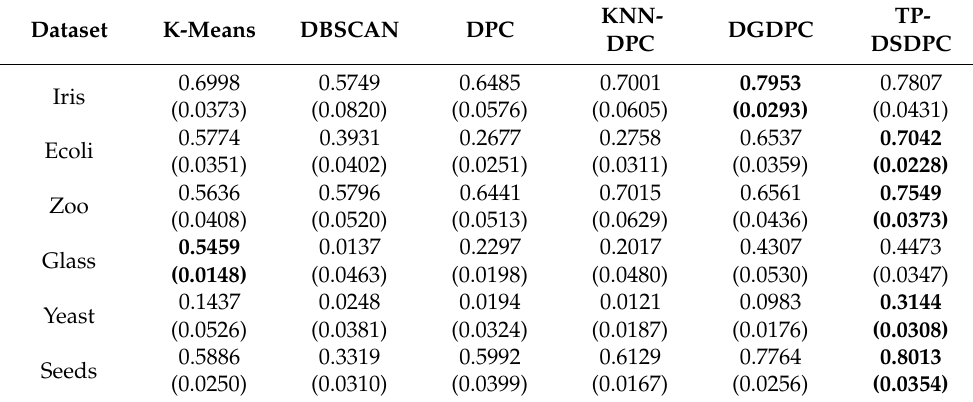
Table 10. Results of ARI on UCI